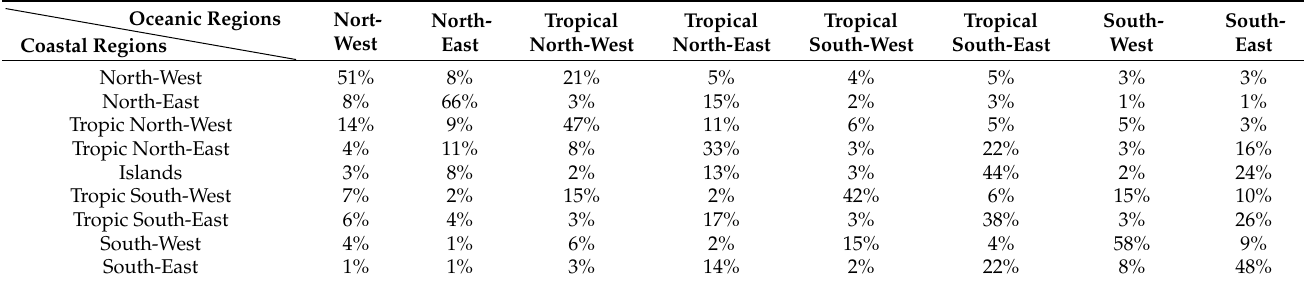
Table 1. Repartition (in %) of all extreme coastal wave occurrences accumulated along nine different coastal regions, delineated by the colored dots on Figure 1b, according to their oceanic origin. RegionsOceanic Regions Nort- North- West Coastal